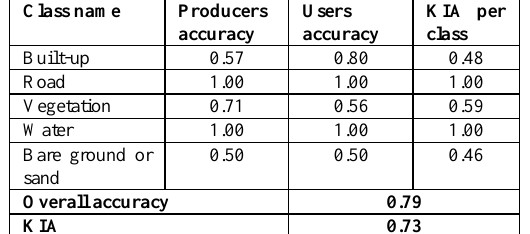
Table 2: Accuracy assessment and kappa statistics for object-based classification (segments based on only spectral